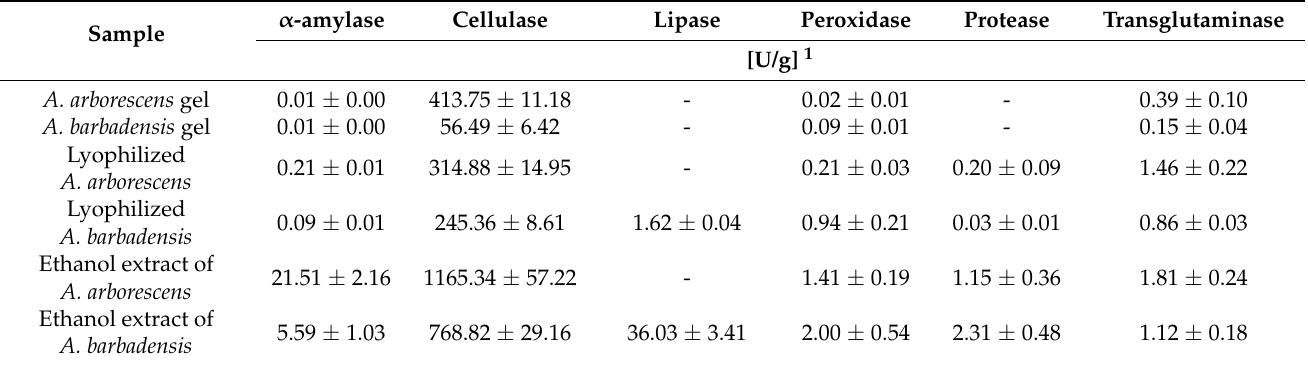
Table 3. Enzyme activities in A. arborescens and A. barbadensis